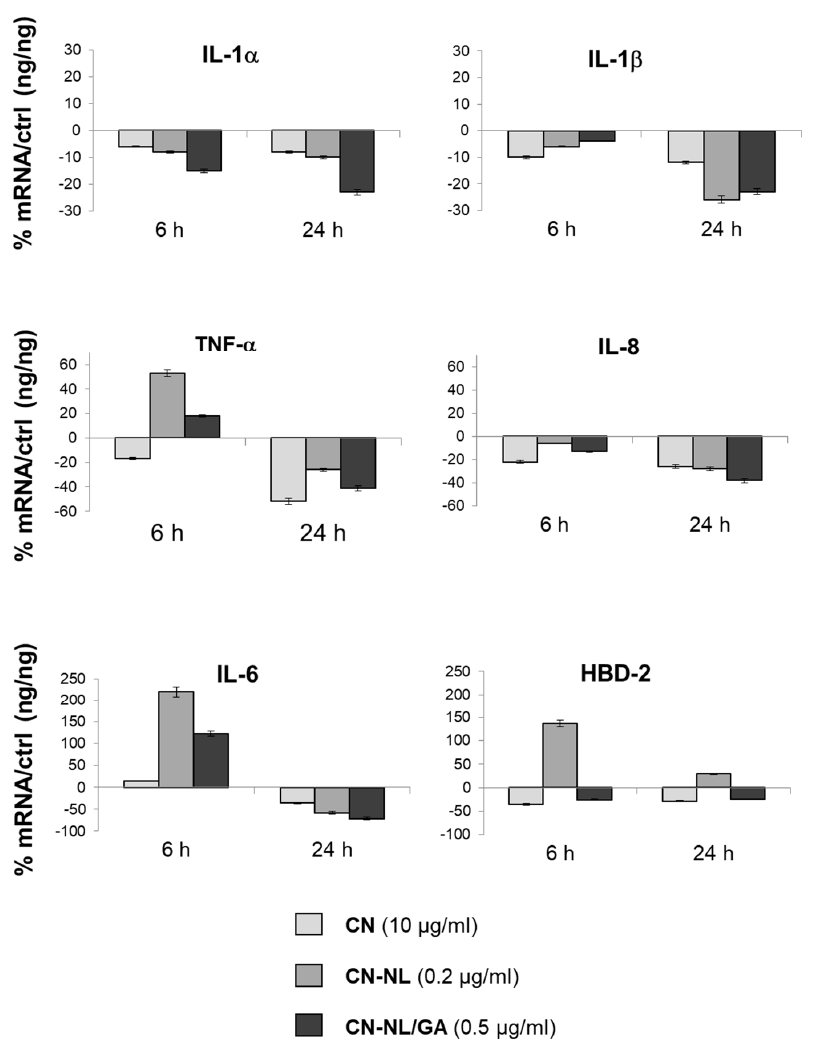
Figure 10. Bar graphs showing the results of RT-PCR performed on HaCaT cells exposed to the biopolymer nanomaterials al 6 h and 24 h for different cytokines involved in inflammatory response and HBD-2 and an antimicrobial peptide. The results are normalized by the expression in untreated cells as control.